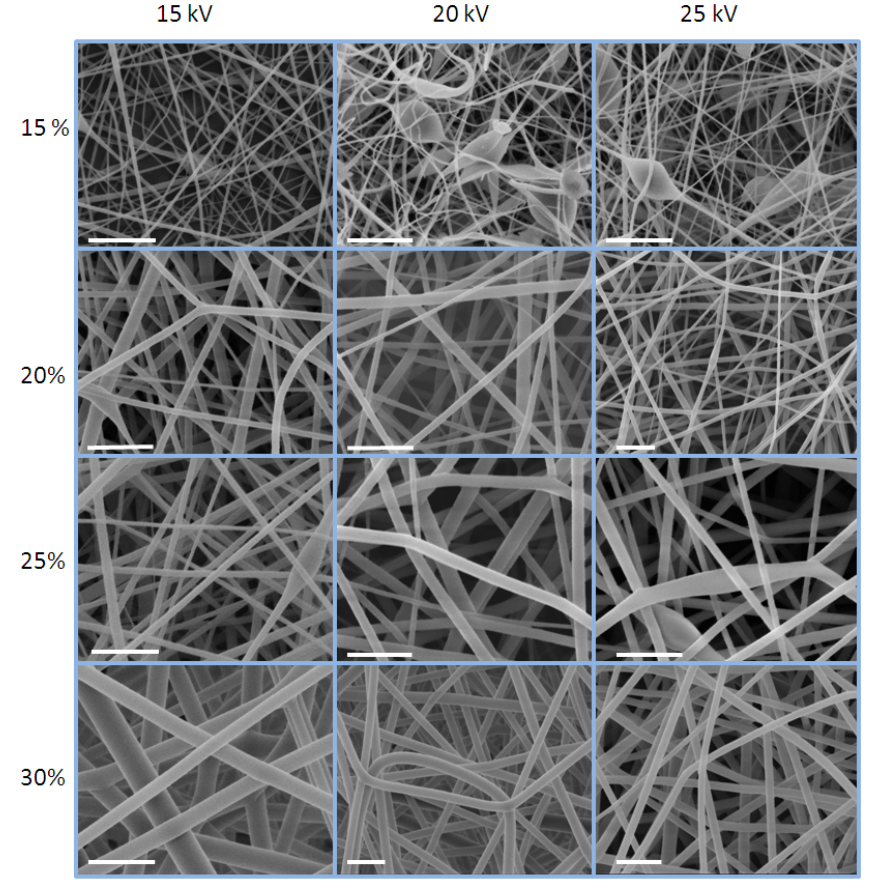
Figure 3. Effects of the phenoxy concentration (at a fixed DMF/THF volume ratio of 30/70) and voltages on the morphology of the electrospun nanofibres (scale bars are 5